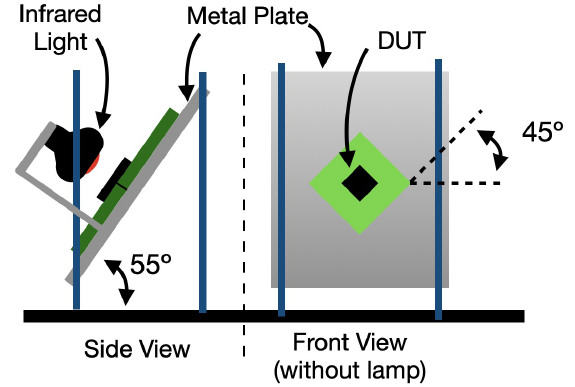
Figure 4. Proposed mechanical structure to perform the calibration tests.